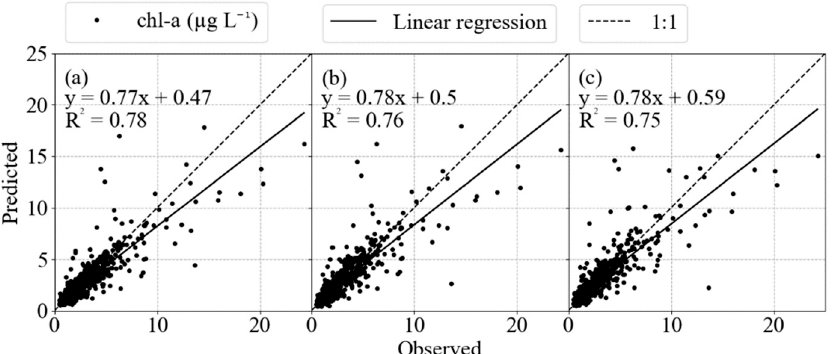
Figure 8. Cross-plots of the modeled and observed chlorophyll values in ( a ) SVR, ( b ) MLP and ( c ) RF. It is possible to notice the deviation in extreme values, showing the limitation of the ML models in deal with these data values.